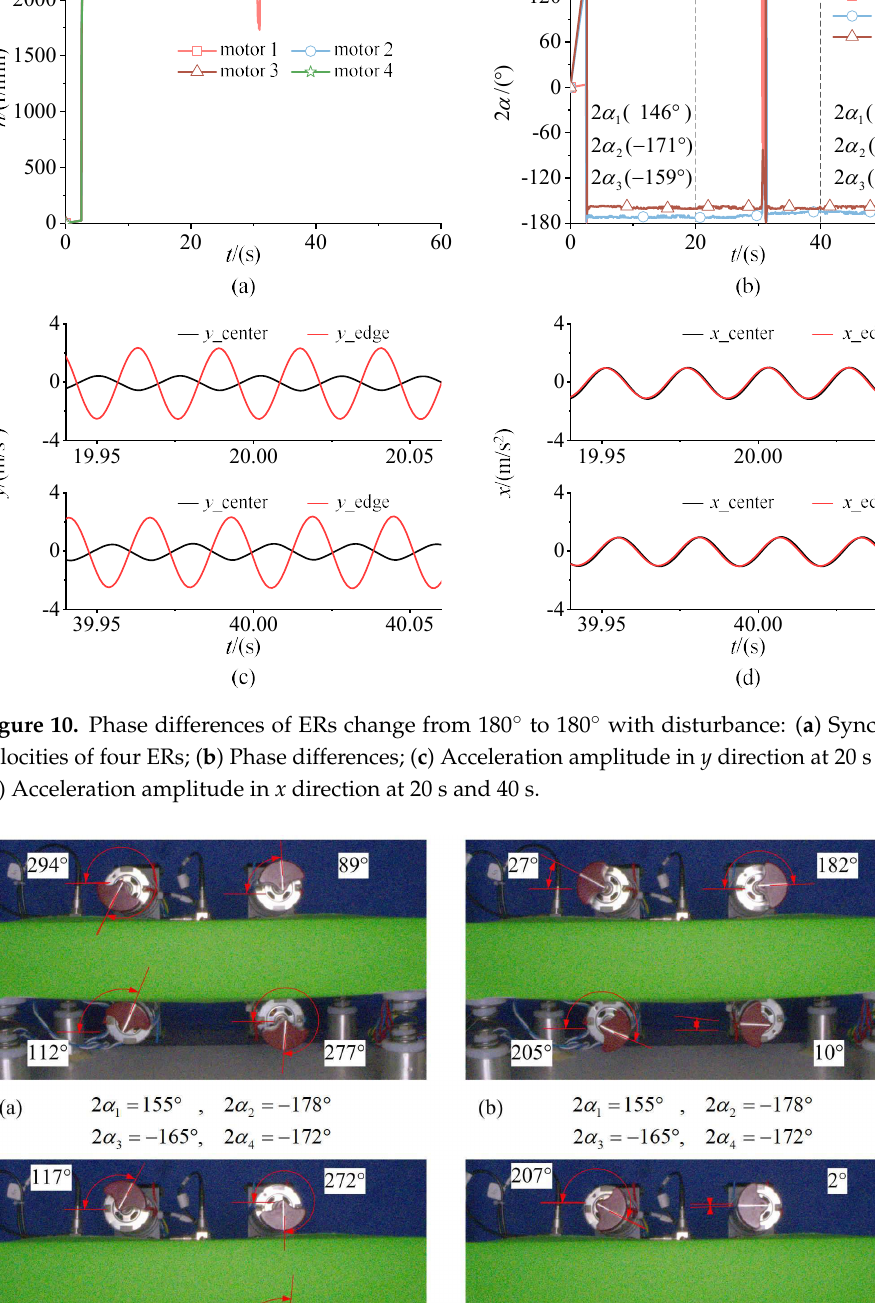
Figure 11. Phase images of 180 in super-resonance during one period of motion.